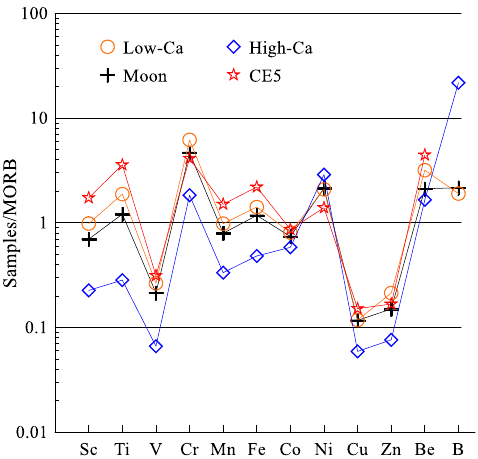
Figure 6. Spider diagrams of moon samples on first transition elements plus Be and B normalized to the MORB. Abundances of the MORB are from White and Klein [14]. the MORB. Abundances of the MORB are from White and Klein